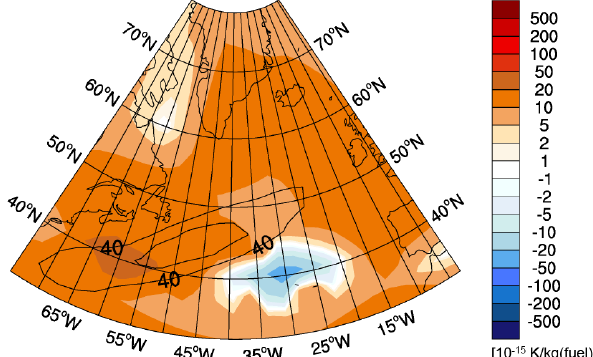
Figure 16. Merged climate change functions in 10 − 15 K per kilo- gram of fuel of aviation-induced total NO x , contrail cirrus, and H 2 O at 250hPa exemplarily for weather situation S2 for an emission at